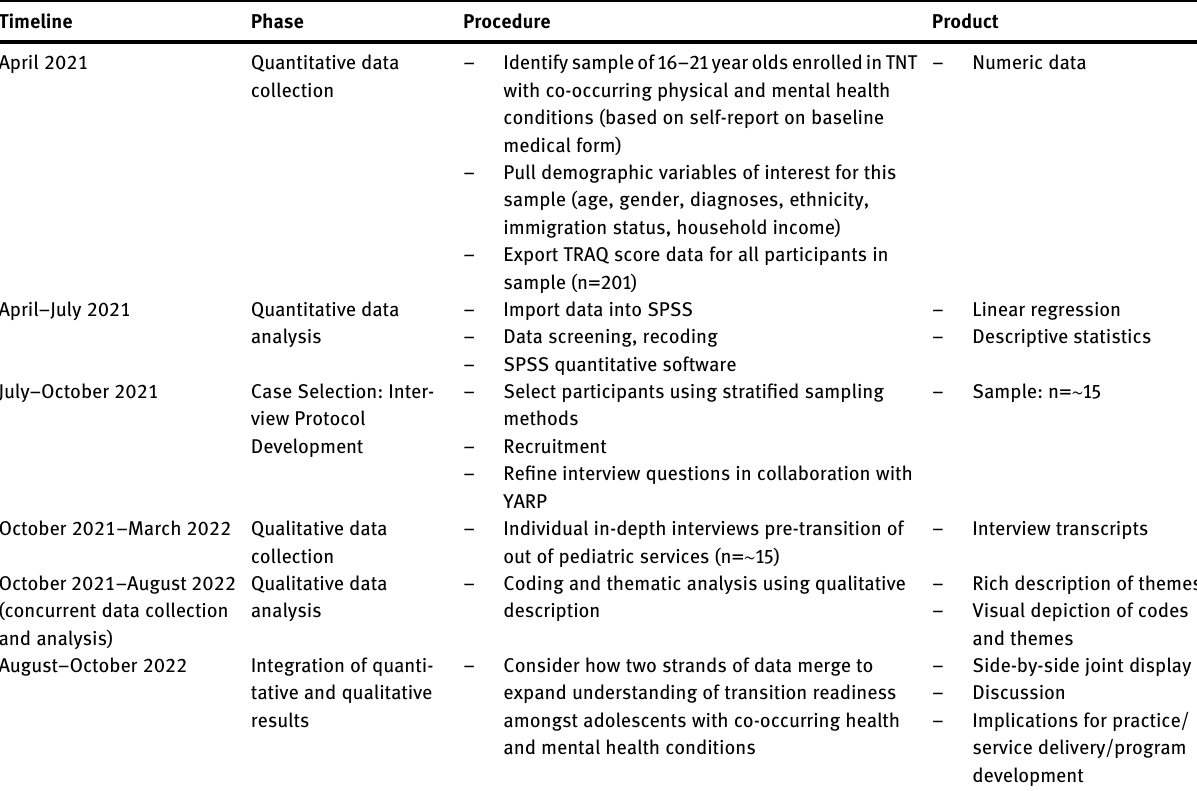
Table  : Mixed methods procedures and products by